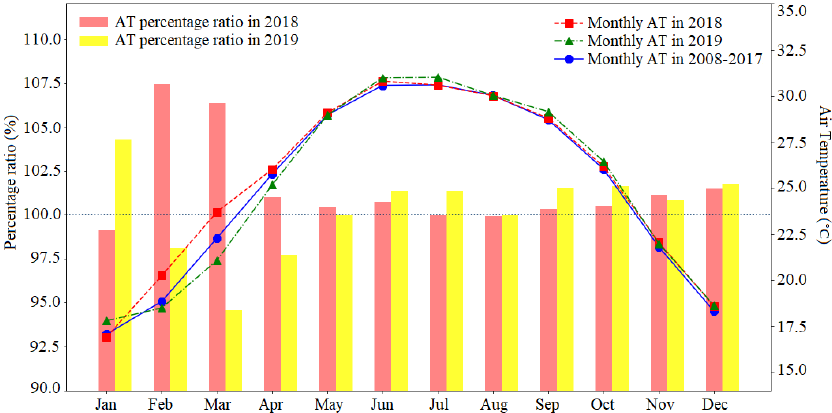
Figure 4. Air temperature and its percentage ratio over part I of the study area during